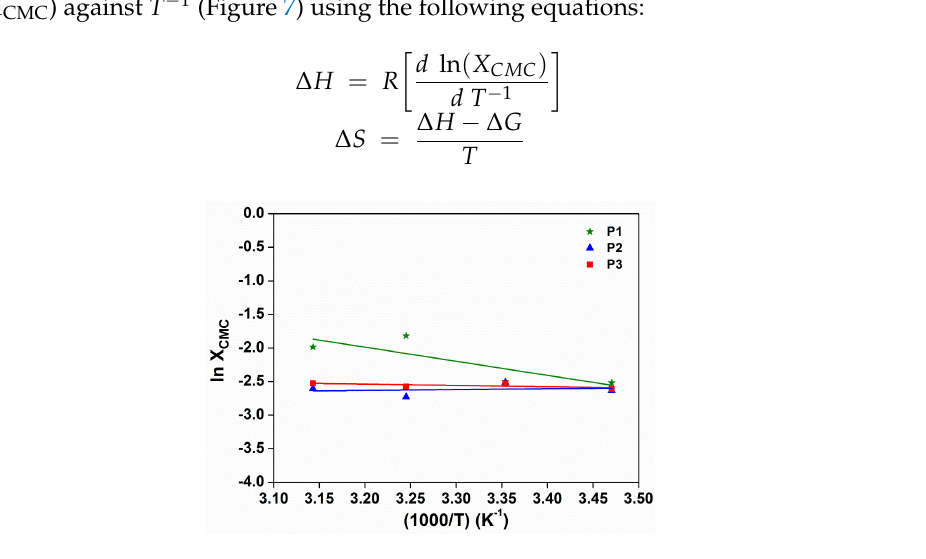
Figure 7. Arrhenius plot of ln( X CMC ) against T −1 for the determination of ∆ H micellization of poly(PEG/PPG/PTHF carbonate urethane) copolymers.